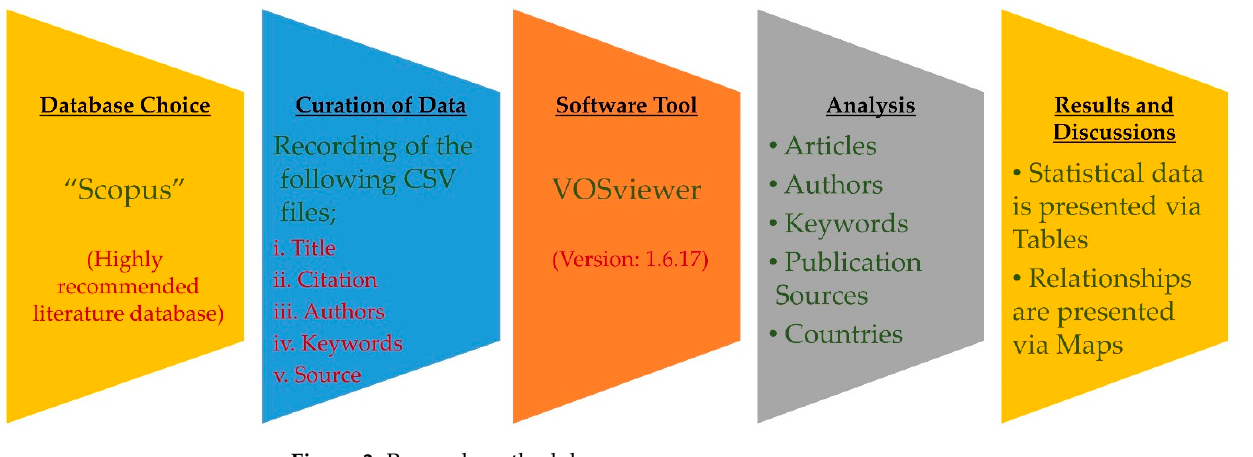
Figure 3. Research methodology